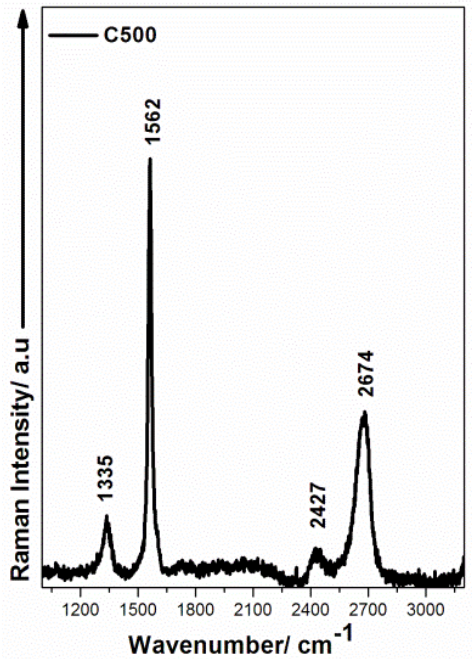
Figure 9. The Raman spectra of C500 graphene fillers in the bio-PA1010 samples. Excitation laser: 532 nm.